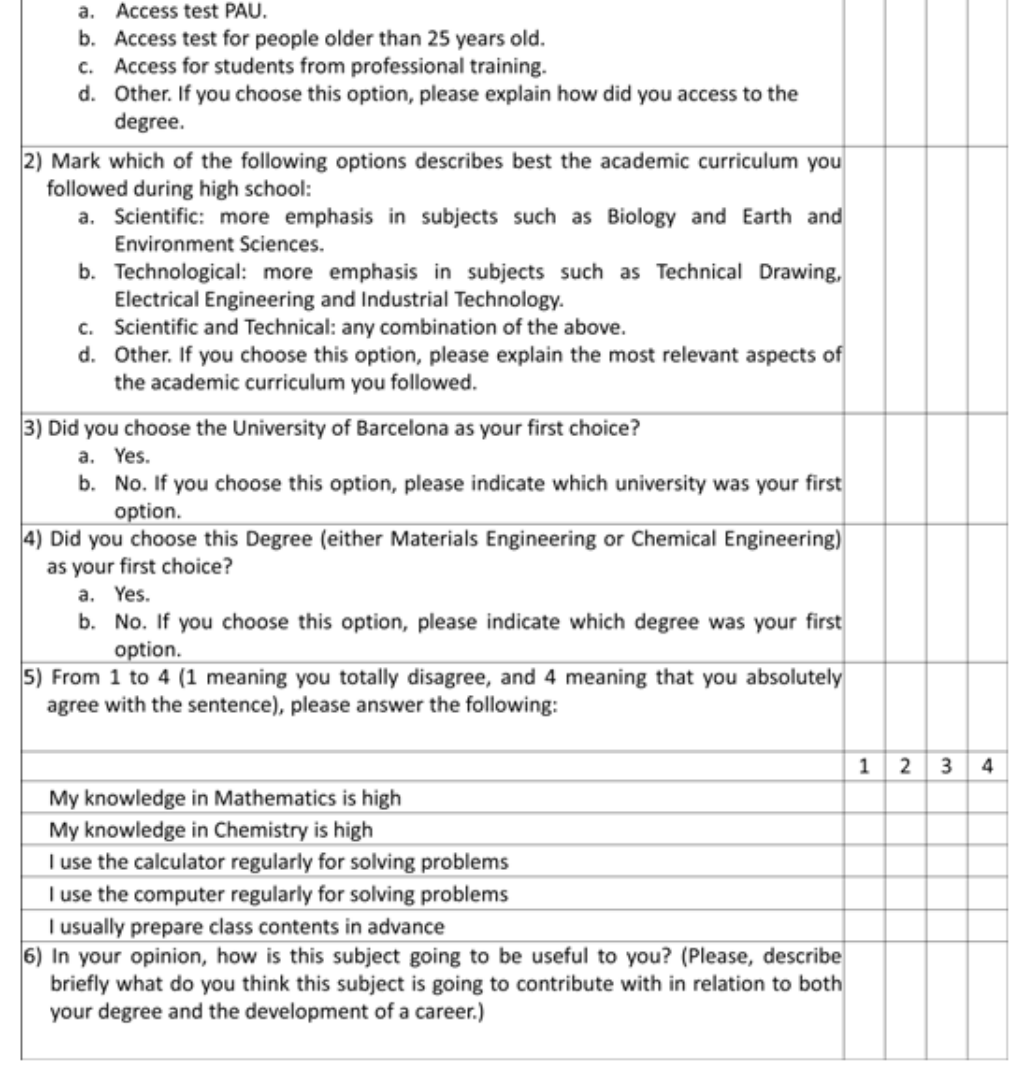
Figure 1. Diagnostic